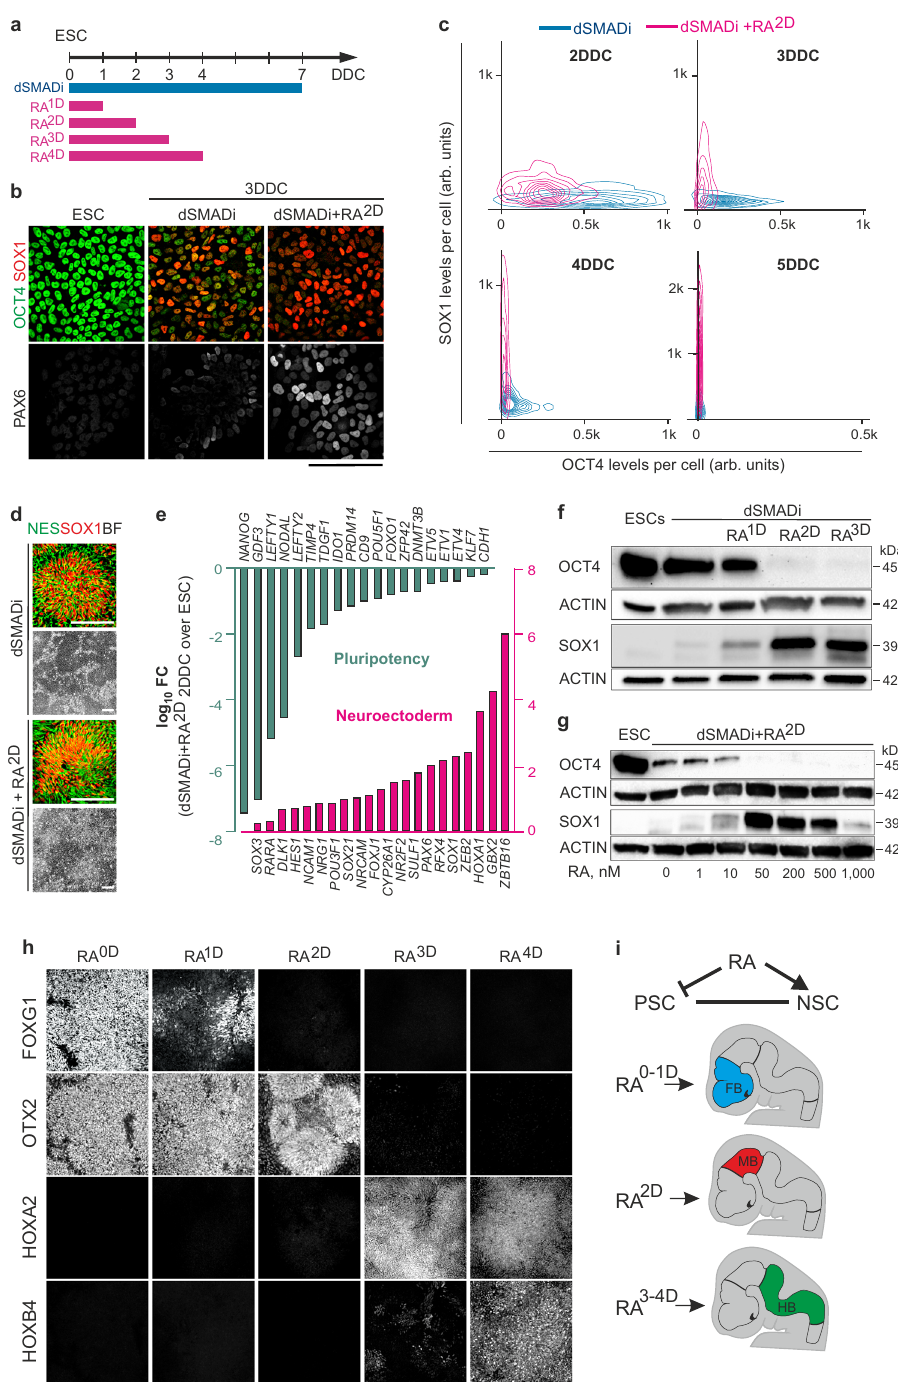
Fig. 1 A two-day RA-pulse results in a rapid induction of NSCs expressing a MB-like identity. a Schematic of hPSC differentiation with timeline of treatment with dSMADi and RA. b Immunocytochemistry for the pluripotency marker OCT4 and neuroectodermal markers SOX1 and PAX6 on ESCs and 3-day cultures differentiated in dual SMAD inhibitors (dSMADi) or in dSMADi with a two-day RA-pulse (dSMADi + RA 2D ). c Density plot of single cell expression of SOX1 and OCT4 in cultures differentiated in dSMADi or dSMADi + RA 2D at indicated days in differentiation conditions (DDC). 670-760 cells per condition and time point were quanti fi ed in a representative differentiation. d Immunocytochemistry for neural progenitor markers NES and SOX1, and bright- fi eld (BF) images of cultures at 7 DDC differentiated in the indicated conditions. e RNAseq-based log 10 fold change values of expression of genes associated with pluripotency or neuroectodermal fate in dSMADi + RA 2D cultures at 2 DDC relative to ESCs. P value and FDR in Supplementary Table 1, n = 2 independent experiments. f Representative western blot for OCT4 and SOX1 of ESC and 3 DDC cultures differentiated in indicated conditions. g Representative western blot for OCT4 and SOX1 of ESC and 3 DDC cultures grown in dSMADi-conditions and treated with indicated concentrations of RA for two days. h Immunocytochemistry for markers identifying forebrain (FOXG1), forebrain and midbrain (OTX2), hindbrain (HOXA2), and caudal hindbrain (HOXB4) regions in nine DDC cultures differentiated in dSMADi and treated with RA as indicated. i Summary of the effects of RA-pulse duration on NSC ’ s regional identity. Scale bars, 100 µ m. Arb.units arbitrary units, FB forebrain, MB midbrain, HB hindbrain. NATURE COMMUNICATIONS| (2022) 13:3046